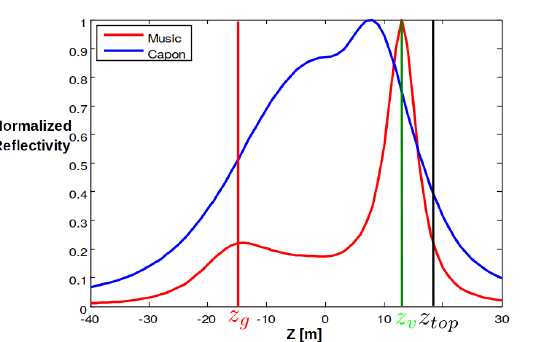
Figure 12. Proposed tomographic approaches for estimation tree height.